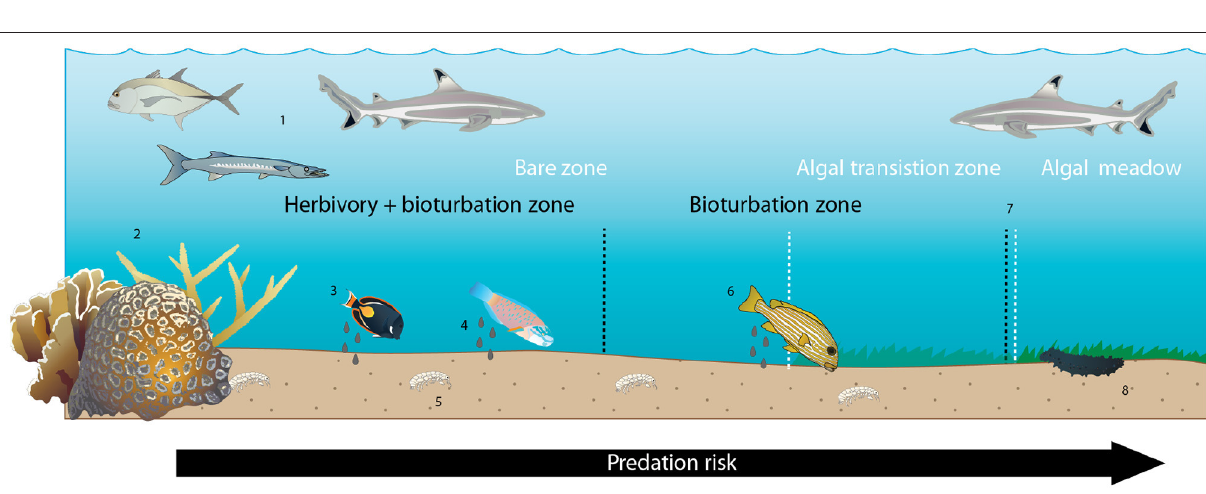
foraging patterns that are consistent with halo